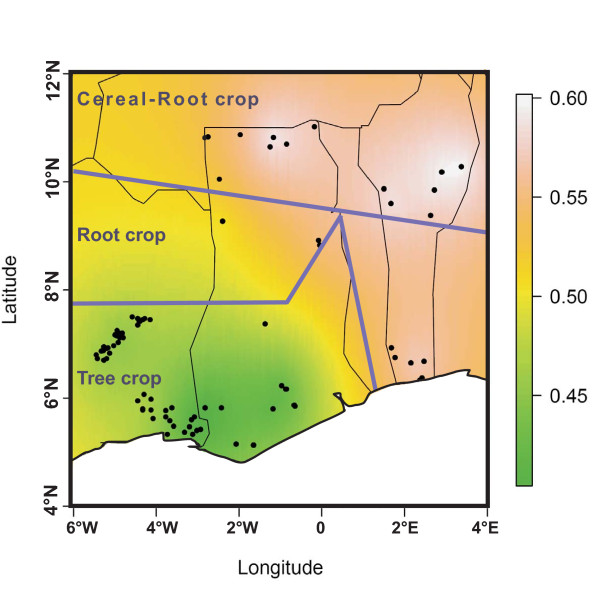
Geographical interpolation of structure result (K = 2) on individual probabilities to belong to cluster 1 (q membreships from 0.4 (green) to 0.6 (white), for local chicken samples from Benin, Côte d’Ivoire and Ghana (latitude and longitude in degrees). Major Farming Systems (MFS) are indicated according to Dixon et al.[42]. The purple lines delineate the MFS.